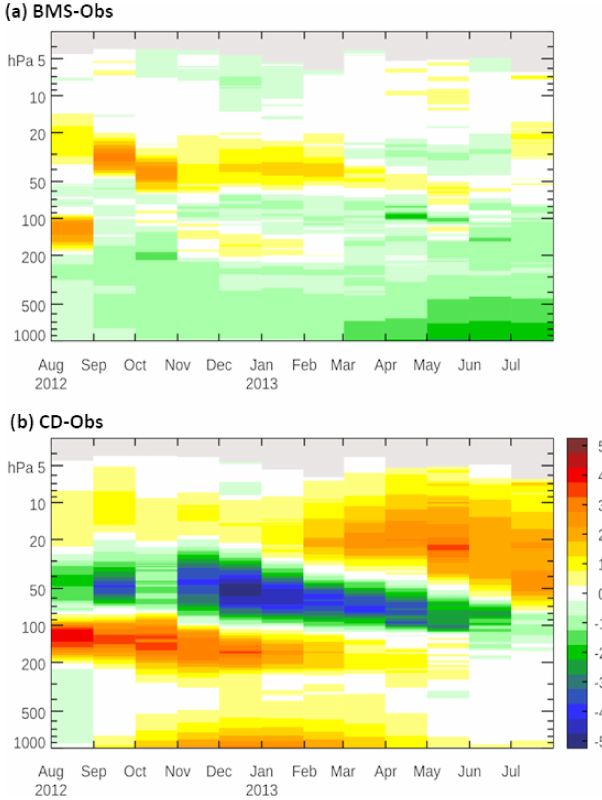
Figure 2. Differences (mPa) with respect to ozone sonde obser- vations for the monthly averaged ozone vertical profiles shown in Fig. 1; differences shown (model − observations) are for (a) the model experiment using the BMS ozone scheme and (b) the model experiment using the default CD